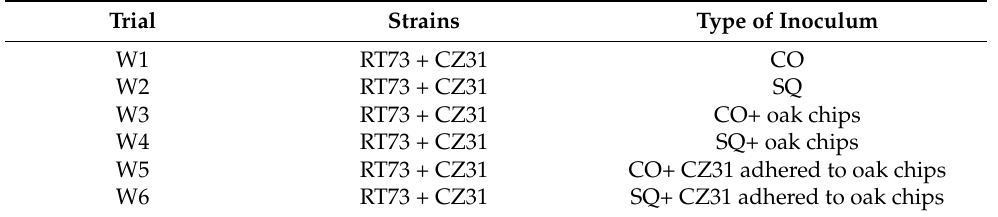
Table 1. Fermentation trials performed in this